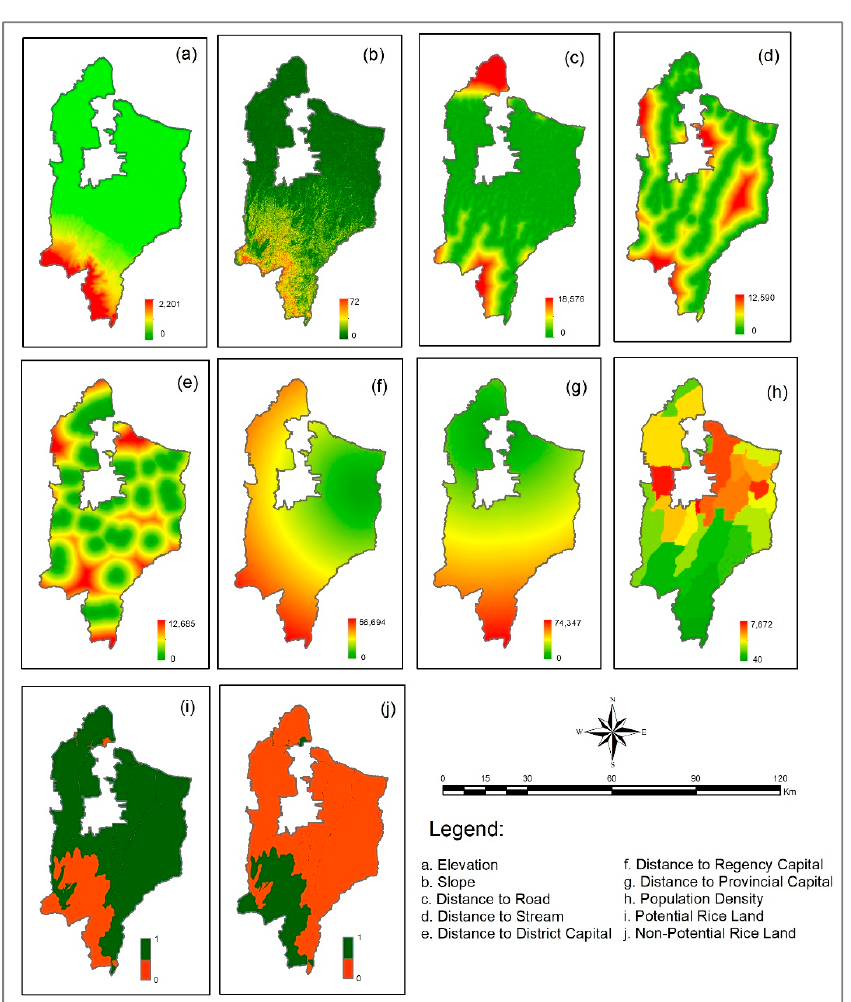
Figure 6. Biophysical factors affecting rice land change (elevation ( a ), slope ( b ), distance to road ( c ), distance to stream ( d ), distance to district capital ( e ), distance regency capital ( f ), distance to provincial capital ( g ), population density ( h ), potential for rice land ( i ), and non ‐ potential for rice land ( j )).